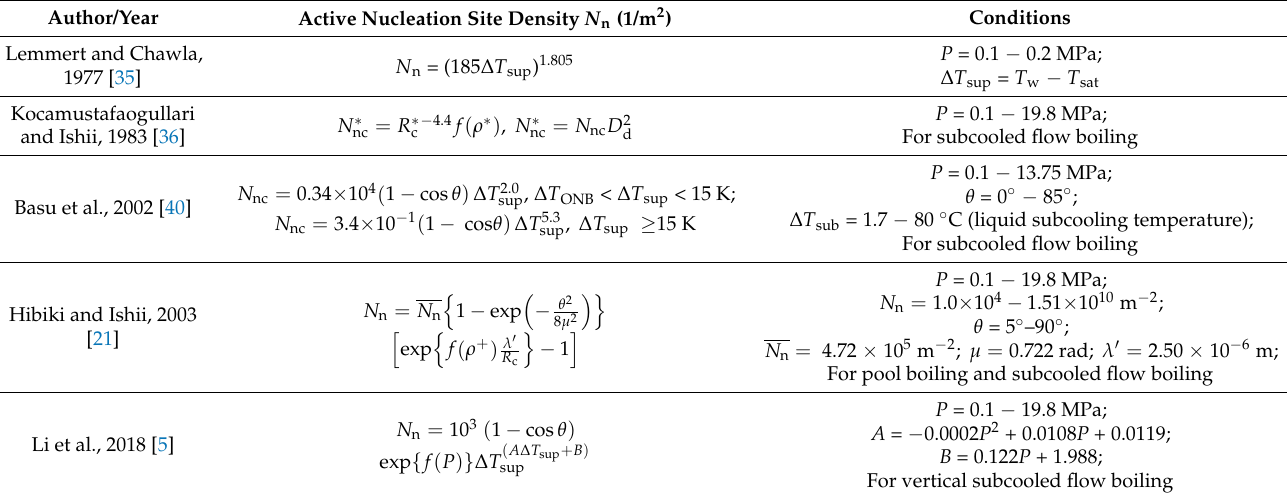
Table 2. Typical models of active nucleation site density N